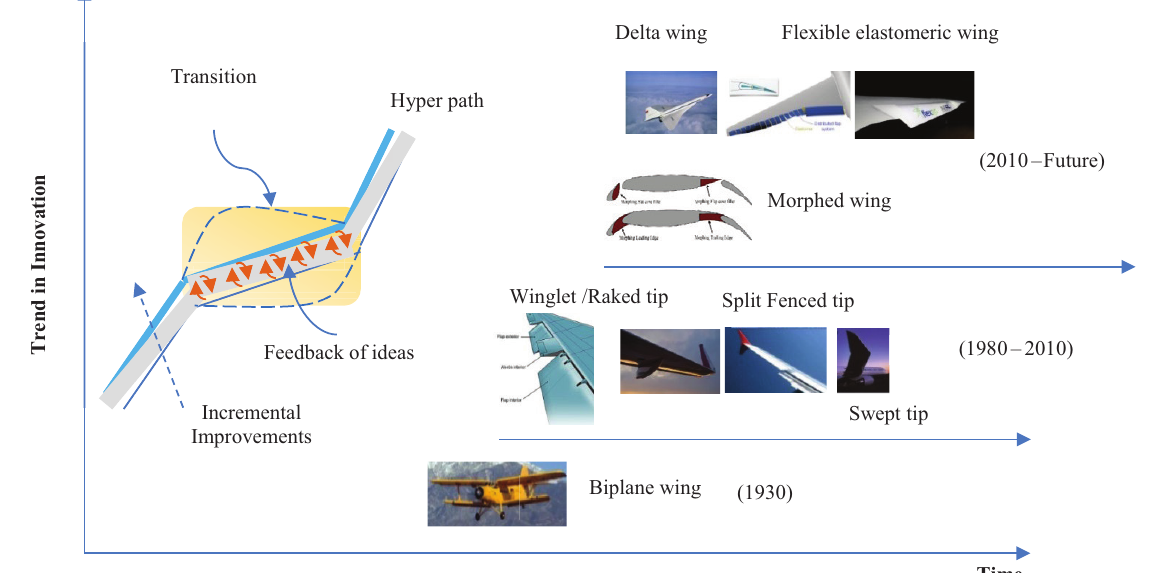
Figure 2. A roadmap of innovation cycle compared to evolution of aircraft wing innovations (adapted from Husse,